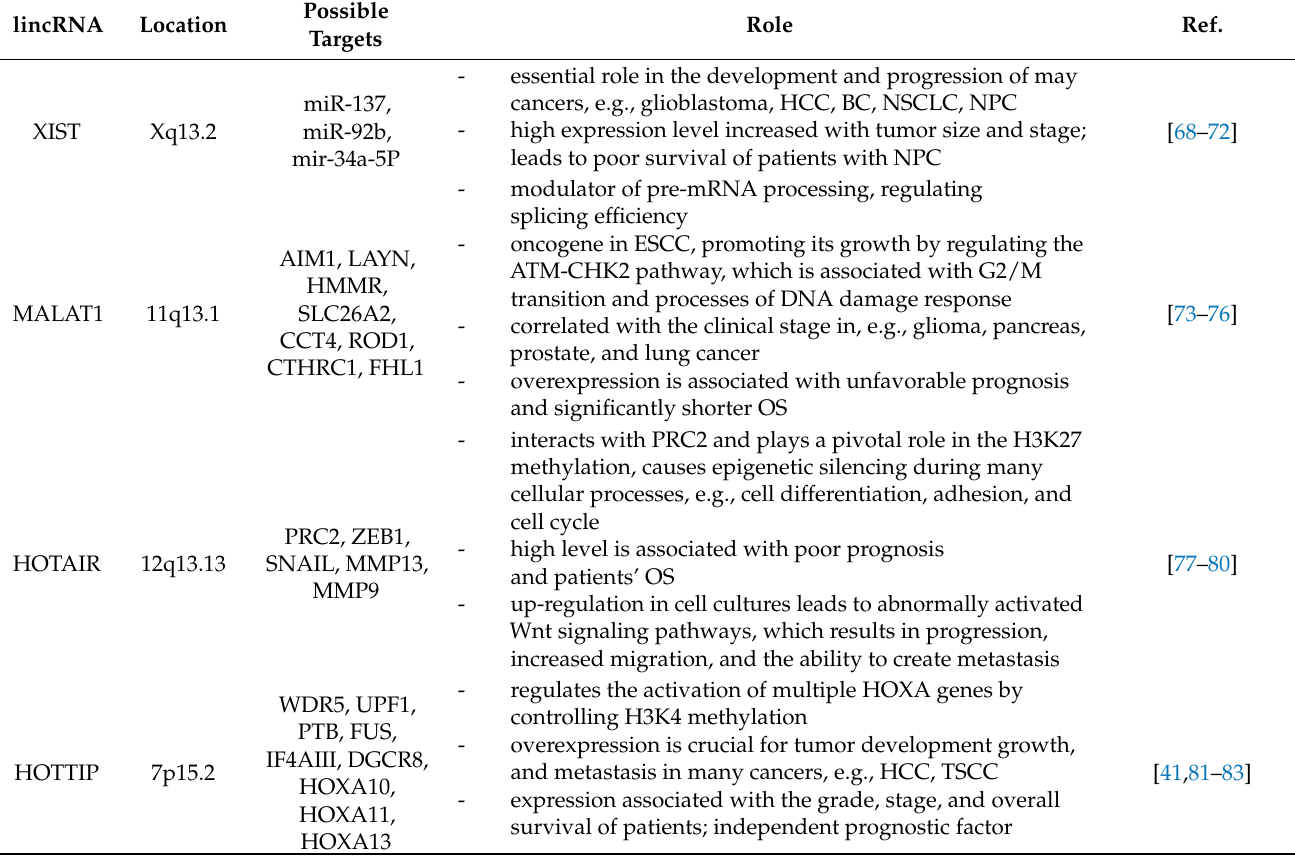
Table 1. The summary of the well-described lincRNAs in HNSCC and other cancers. Role